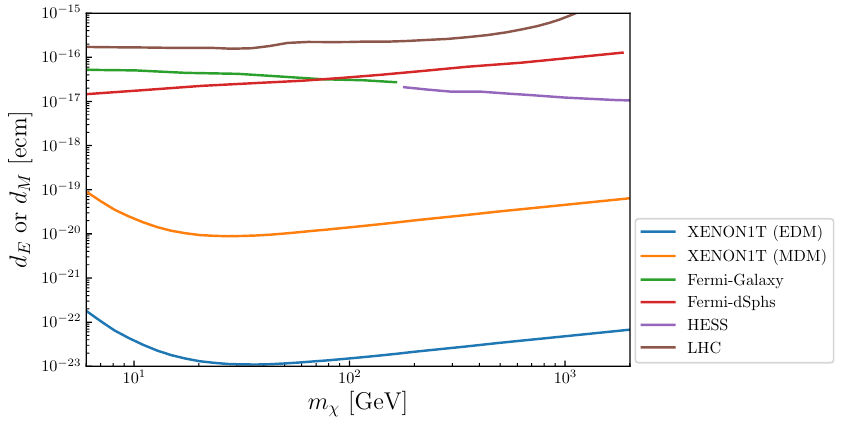
Figure 5 . Comparison of direct detection bounds with other known bounds on DM elec- tric/magnetic dipoles. The direct detection bounds (XENON-1T) are the same as those in figure 4. The CMB bound is taken from ref. [21]. The indirect detection bounds, taken from ref. [59], are derived from FERMI-LAT constraints on γ -rays from the Galaxy (labelled as FERMI-Galaxy) and dwarf Spheroidal galaxies (FERMI-dSphs). The collider bound is obtained from LHC mono-jet searches